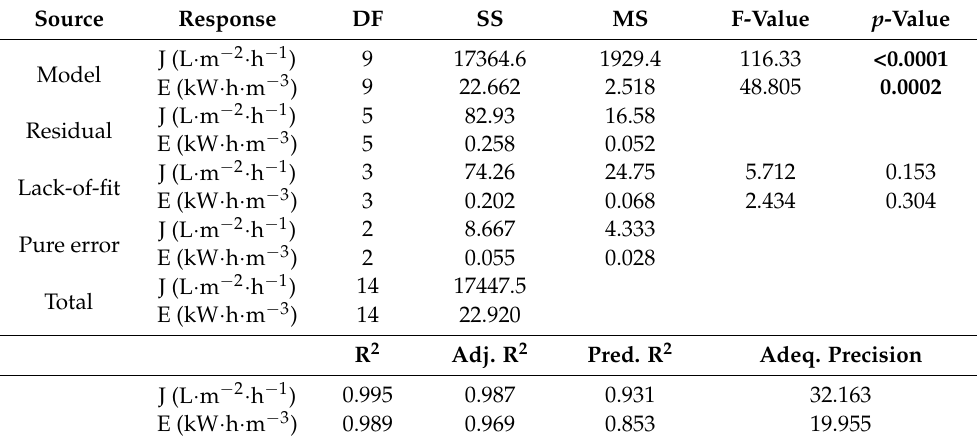
Table 3. ANOVA of regression models for steady-state permeate flux and specific energy consumption for broth SMGS microfiltration